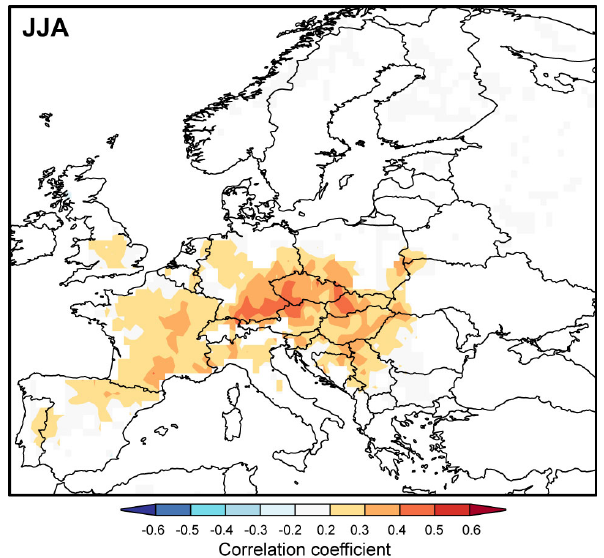
Figure 16. Spatial correlations between reconstructed Czech JJA scPDSI series (Brázdil et al., 2016) and the gridded European JJA scPDSI reconstruction (Cook et al., 2015) for the 1501–2012CE